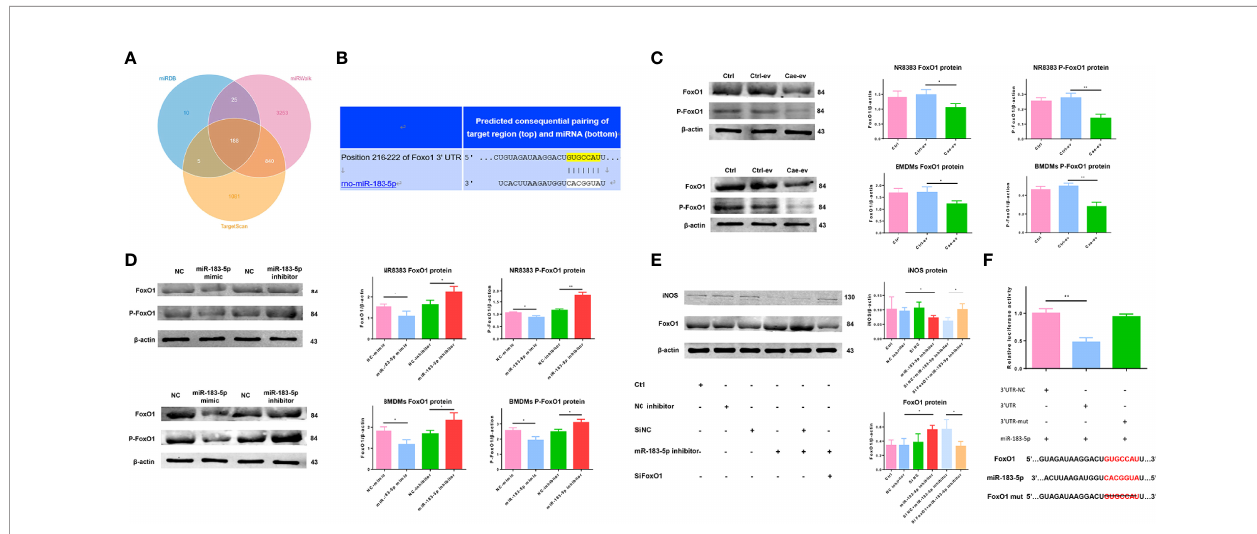
FIGURE 5 | AC-derived EV miR-183-5p induces macrophage M1 polarization by targeting FoxO1. (A) Venn diagram showing the number of potential common target genes identi fi ed by three bioinformatics analysis tools. (B) The presence of a complementary miR-183-5p sequence in the 3 ′ -UTR of FoxO1 mRNA was predicted by TargetScan. (C-D) Western blotting: (C) levels and analysis of the FoxO1 and P-FoxO1 proteins in NR8383 macrophages and BMDMs treated with Ctrl-ev and Cae-ev; (D) levels and analysis of the FoxO1 and P-FoxO1 proteins in NR8383 macrophages and BMDMs transfected with NC-mimic, miR-183-5p mimic, NC-inhibitor and miR-183-5p inhibitor. (E) Levels and analysis of the FoxO1 and iNOS proteins in BMDMs transfected with the NC inhibitor, miR-183-5p inhibitor, si-NC+miR-183-5p inhibitor and siFoxO1+miR-183-5p inhibitor. (F) A luciferase reporter assay was performed with 3 ′ UTR-NC (negative control), 3 ′ UTR- FoxO1 and 3 ′ UTR-FoxO1-mutant. The miR-183-5p overexpression plasmid and the above constructs were transfected into 293T cells. All experiments were repeated three times. * p <0.05, ** p <0.01, *** p <0.001. Ctrl-ev: EVs derived from PBS-treated ACs, Cae-ev: EVs derived from caerulein-treated ACs, NC-mimic: macrophages transfected with NC-mimic, miR-183-5p mimic: macrophages transfected with miR-183-5p mimic, NC-inhibitor: macrophages transfected with NC- inhibitor, miR-183-5p inhibitor: macrophages transfected with miR-183-5p inhibitor, si-NC+miR-183-5p inhibitor: macrophages transfected with miR-183-5p inhibitor and si-NC, siFoxO1+miR-183-5p inhibitor: macrophages transfected with miR-183-5p inhibitor and